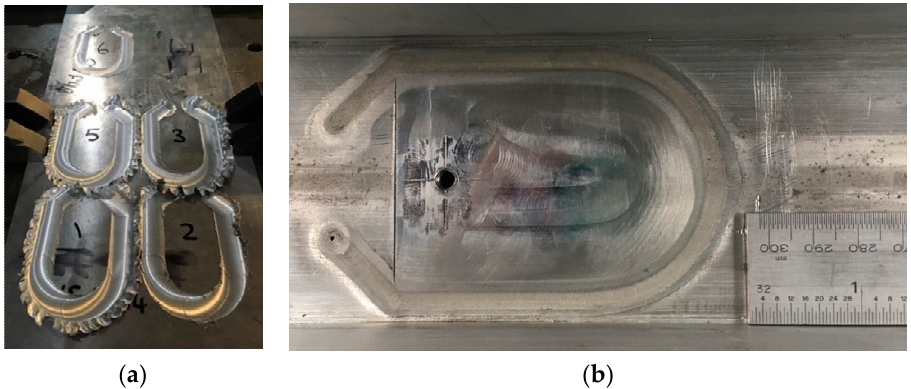
Figure 9. ( a ) Different paths employed, ( b ) actual weld on the C-shaped profile.